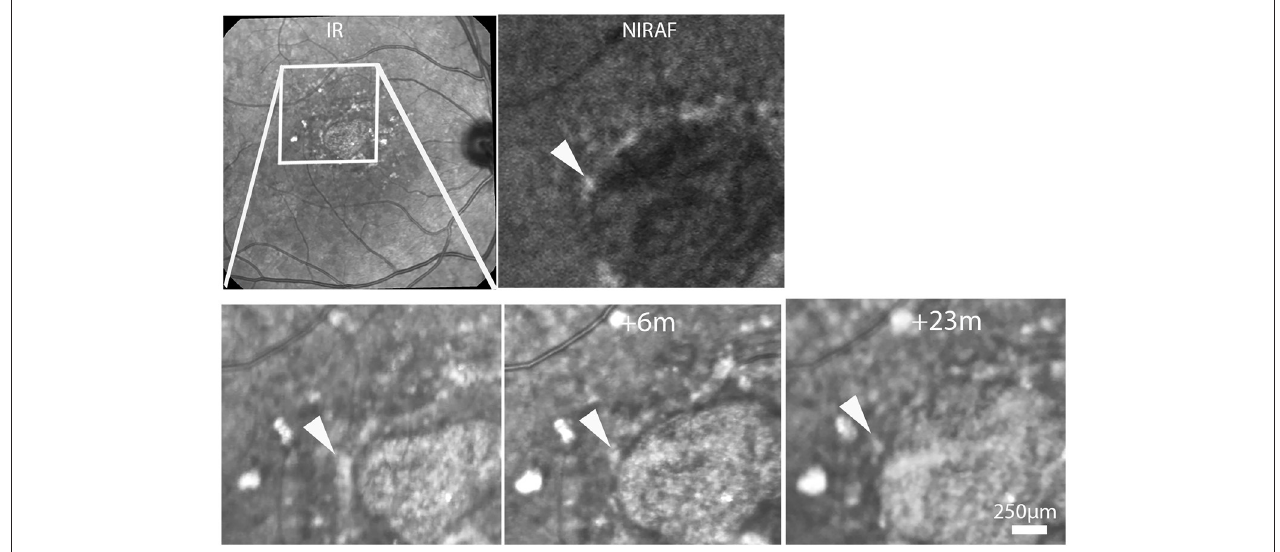
FIGURE 3 | Case 6. Top row, SLO IR and NIRAF images. Bottom row, progression of atrophy. Time-points relative to the first image are indicated in the second and third images. Note the changing aspect of the hyperreflective spot (arrowheads; see also Supplementary Video 2 ).